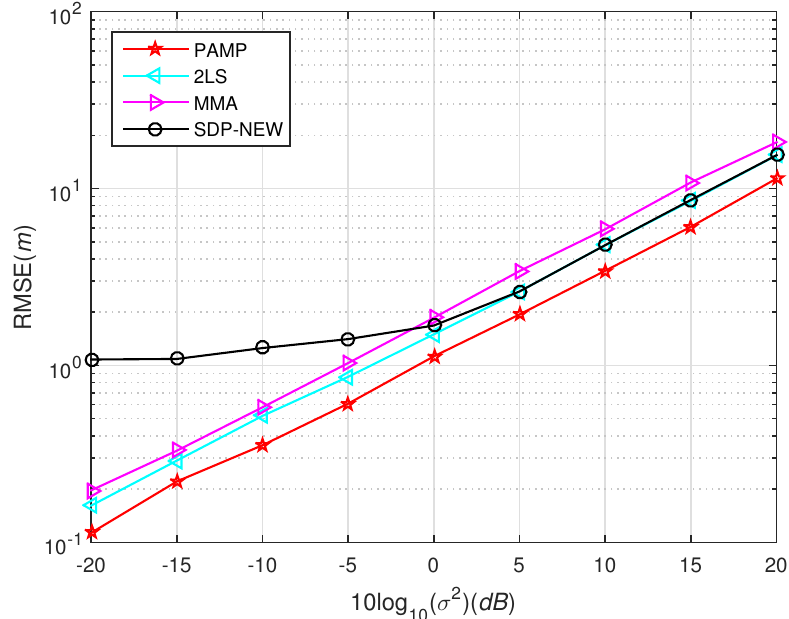
Figure 7. RMSE versus σ 2 using different methods in scenario 2, uniformly distributed